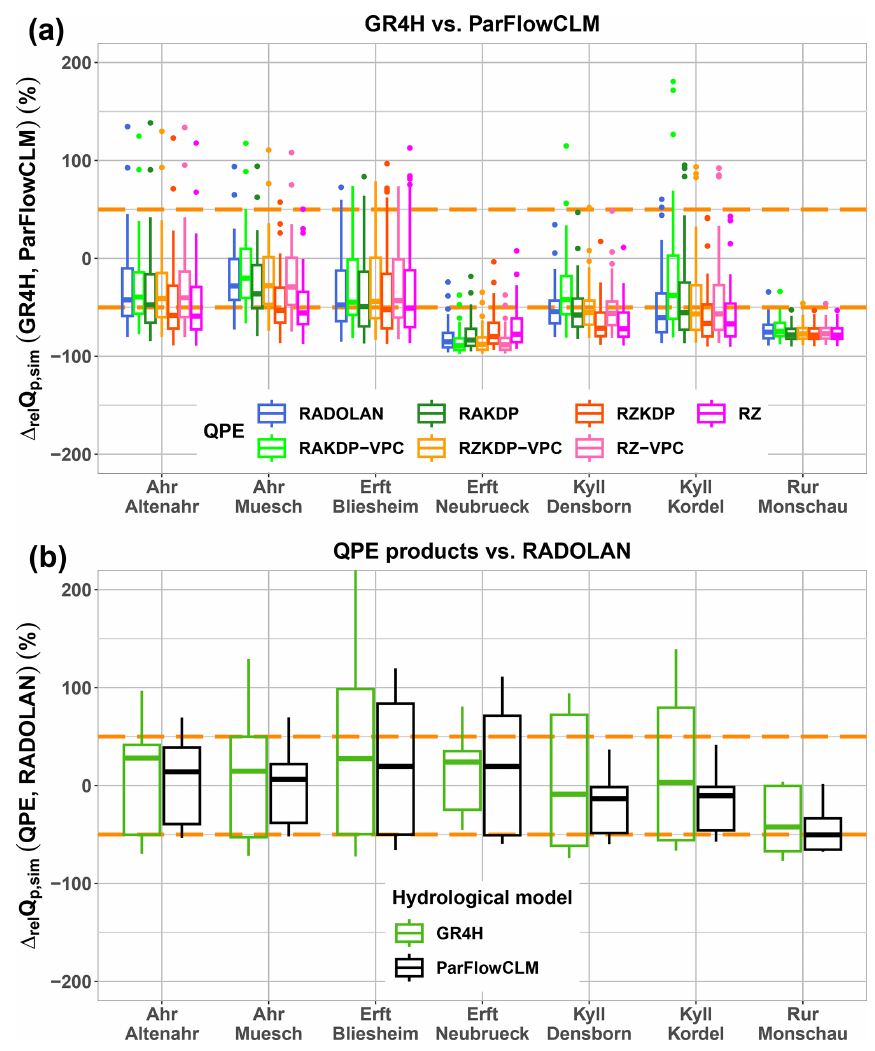
Figure 8. Relative errors in simulated peak flow due to (a) applying GR4H instead of ParFlowCLM across all radar-based QPE products and (b) replacing RADOLAN by any of the remaining seven (or six for ParFlowCLM) hourly QPE products (Table 2) as precipitation input for the July 2021 event. Dashed orange lines limit the 50% relative error